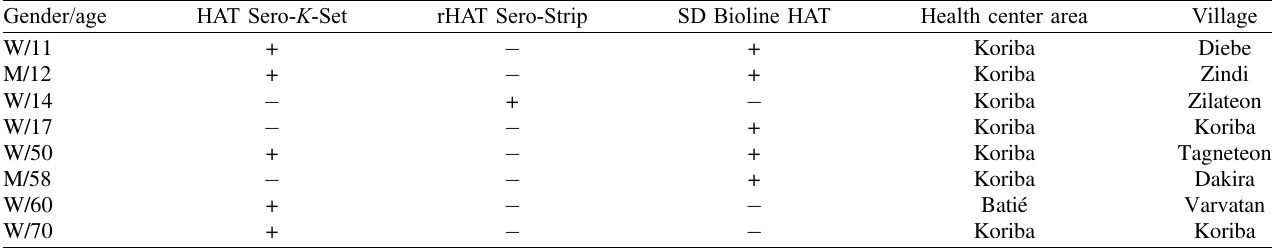
Table 1. Detailed serological and parasitological test results of 8 rapid diagnostic test positives with positive ELISA/ T. b. gambiense . W: women; M: men.